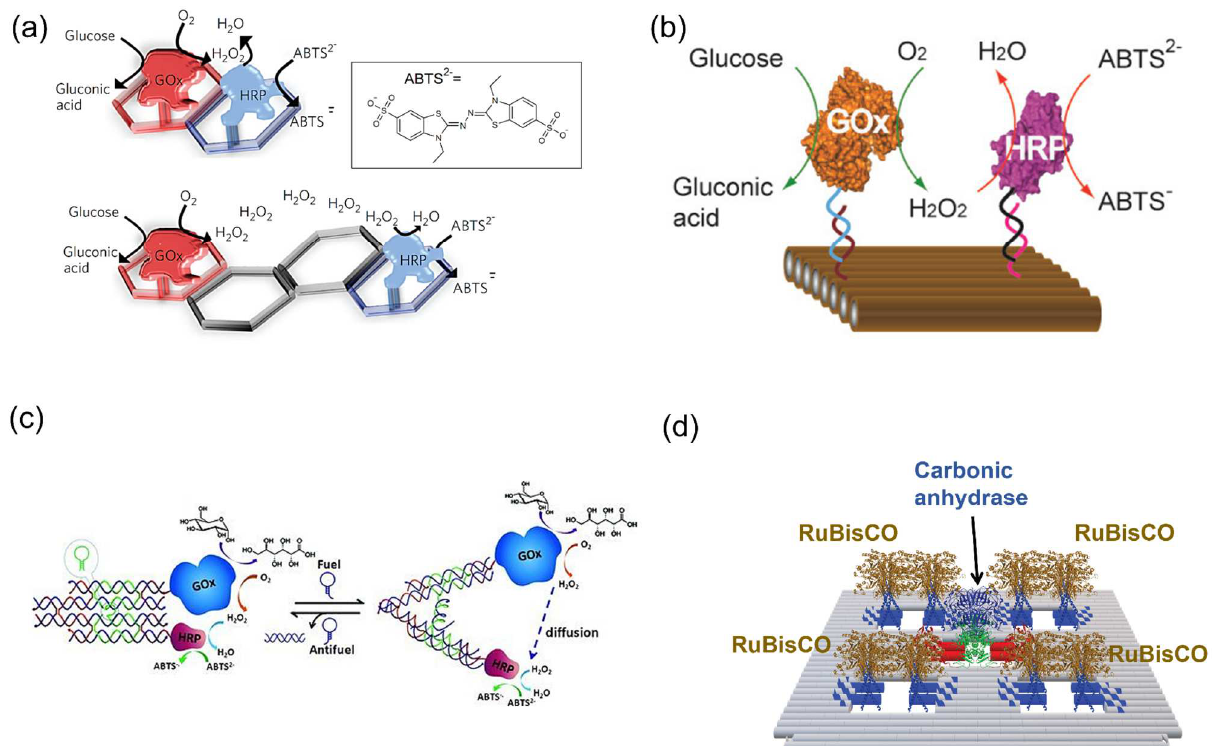
Figure 11. Enzyme cascade reactions on the DNA scaffolds to study the enzyme proximity effect. ( a ) Assembly of the GOx and HRP enzymes on the two-hexagon or four-hexagon strips [94]. ( b ) GOx/HRP assembled on the rectangular DNA scaffold [95]. ( c ) Enzyme cascade reaction of GOx and HRP was regulated by a dynamic DNA tweezer. The DNA machine contains DNA double crossover (DX) motifs constructing two rigid arms jointed by an immobile four-way junction [96]. ( d ) RuBisCO and carbonic anhydrase co-assembled on a 2D DNA scaffold [100]. Reprinted with permission from: ( a ) Ref. [94]. Copyright 2009 Springer Nature; ( b ) Ref. [95]. Copyright 2012 American Chemical Society; ( c ) Ref. [96]. Copyright 2013 John Wiley and Sons; ( d ) Ref. [100]. Copyright 2019 Elsevier Ltd.